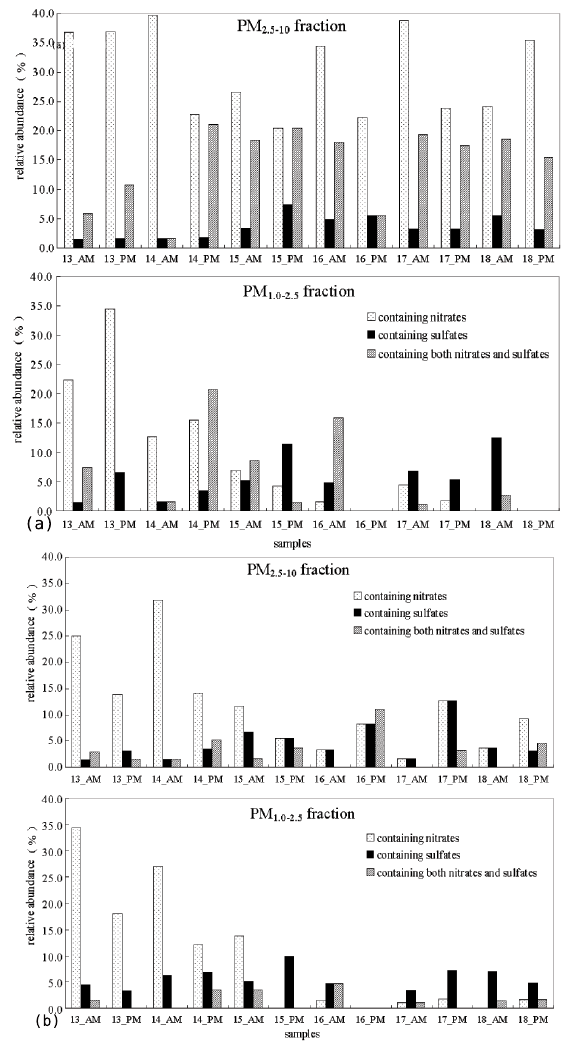
Fig. 7. Relative abundances of (a) reacted mineral dust and (b) re- acted sea-salt particles, containing nitrates, sulfates and both.